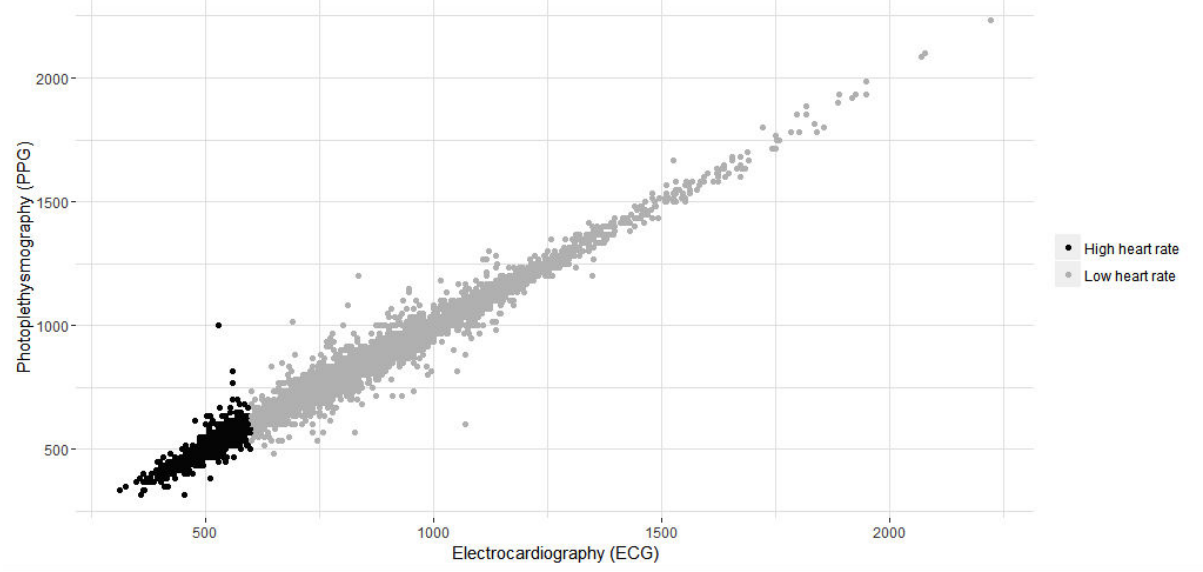
Figure 11. Correlation of intervals for both techniques (ie, electrocardiography [ECG] and photoplethysmography [PPG]) in milliseconds. Gray, high heart rates; Black, low heart rates.